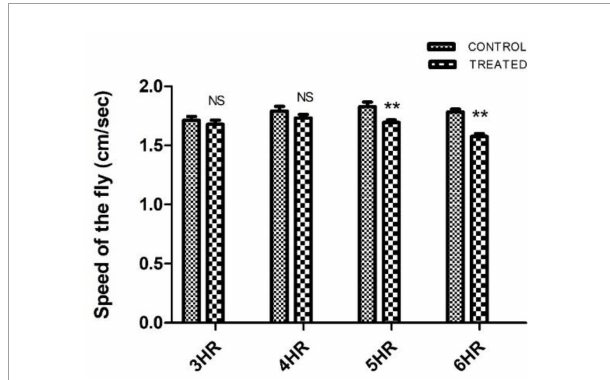
FIGURE1 Characterization of paraquat (PQ) exposure window at which fly does not exhibit motor dysfunctions as determined by negative geotaxis assay: Drosophila male was exposed to 10 mM PQ and 5% sucrose (control) at different time points. A climbing assay was performed to check the motor ability of the fly. Fly started showing motor defects from 5 h of treatment onward. However, there was no significant difference in the motor ability between control and treated flies up to 4 h of treatment, providing an opportunity to understand SD well before the onset of mobility defects. (** signifies P < 0.01; NS: not